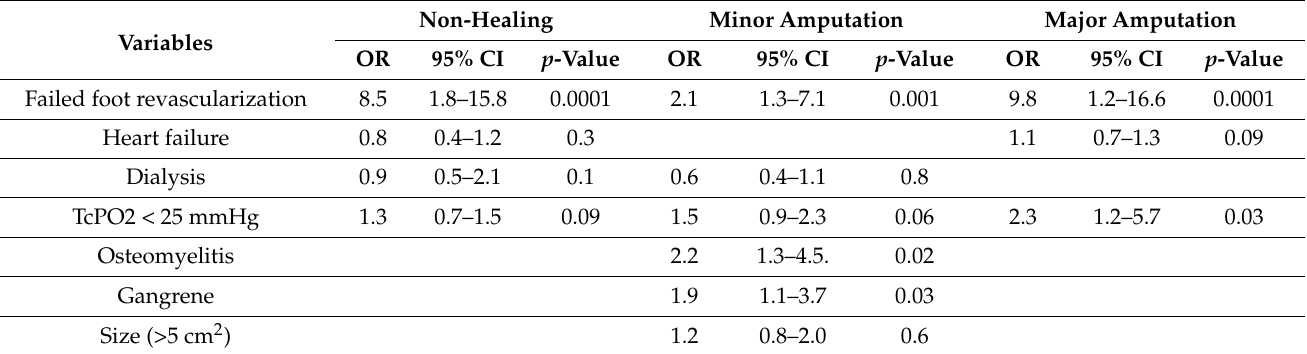
Table 2. Multivariate analysis of independent predictors of outcomes found at univariate